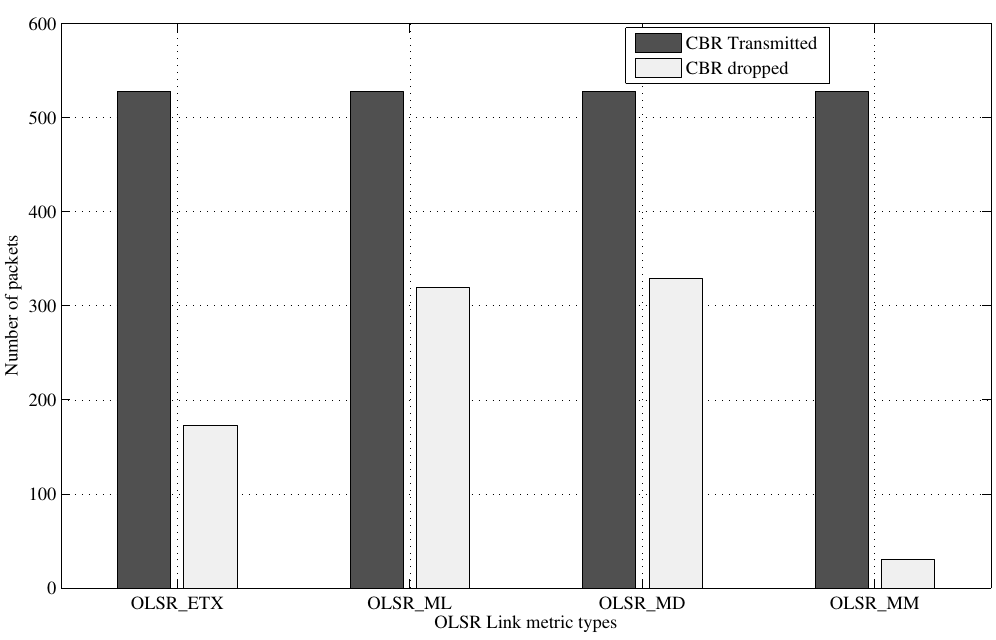
Figure 8. Transmitted and dropped CBR packets for peak pricing.